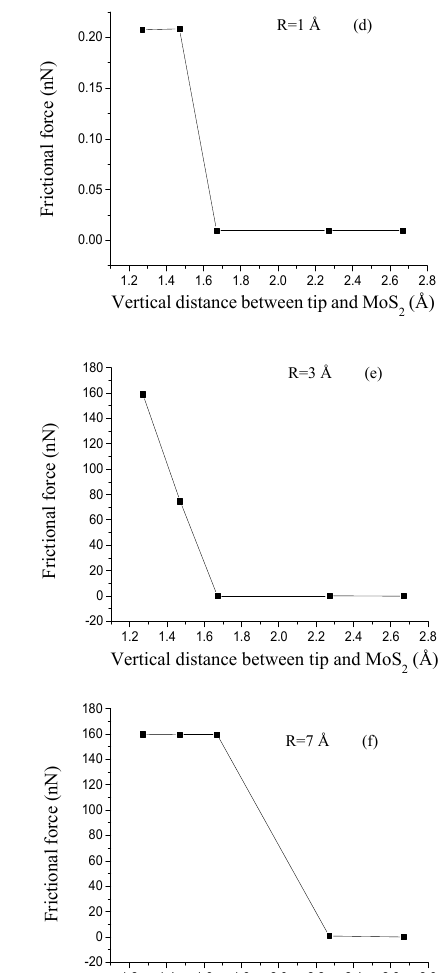
Figure S1: Frictional force–sliding distance curves for various vertical distances (1.27, 1.47, 1.67, 2.27, and 2.67